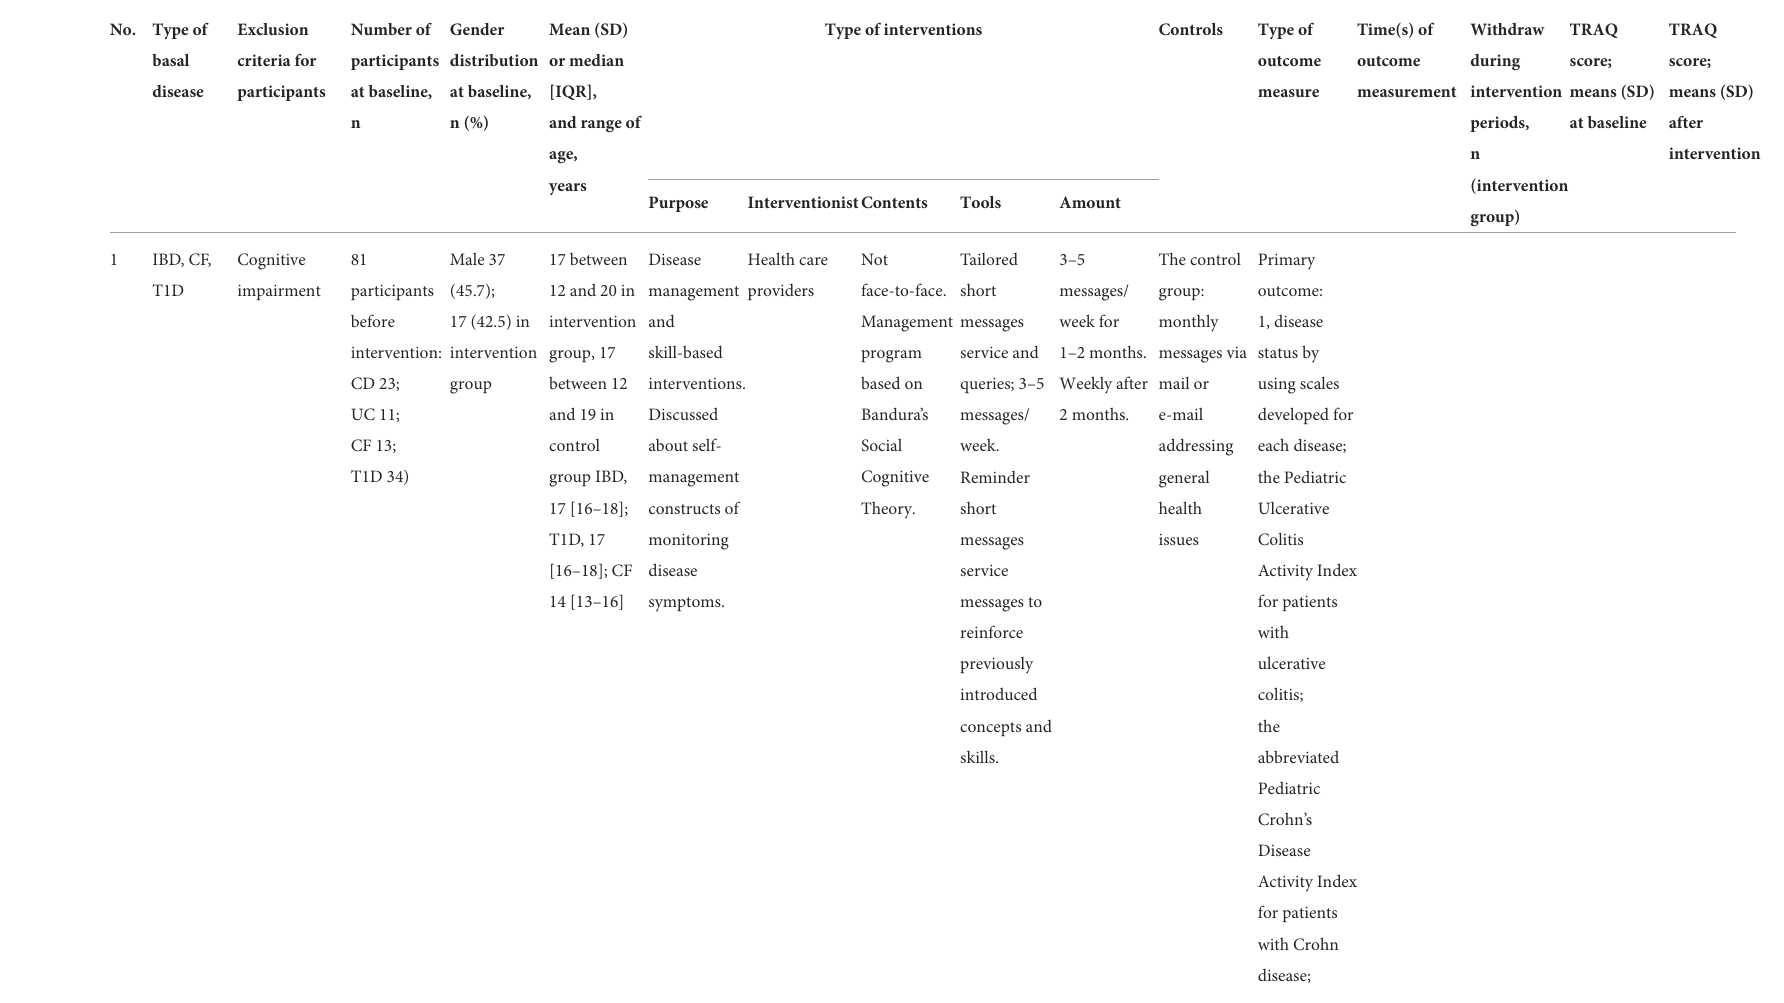
TABLE 2 Characteristics of study patients, interventions, and outcome. No. Type of basal